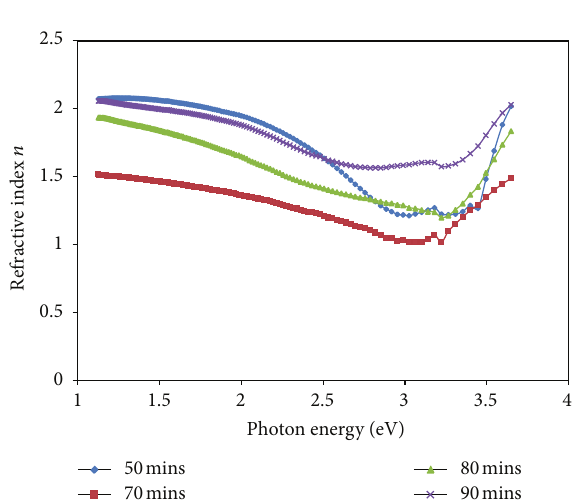
Figure 5: Transmittance versus wavelength.